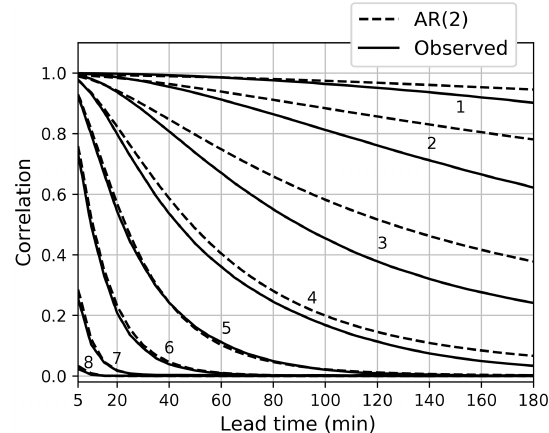
Figure 10. Temporal auto-correlation estimates obtained from AR(2) models (dashed lines) and the correlation between an extrap- olation nowcast and the corresponding observations. The analysis is based on the FMI events (Table 7). The line numbers correspond to the frequency bands shown in Fig. 1 from left to